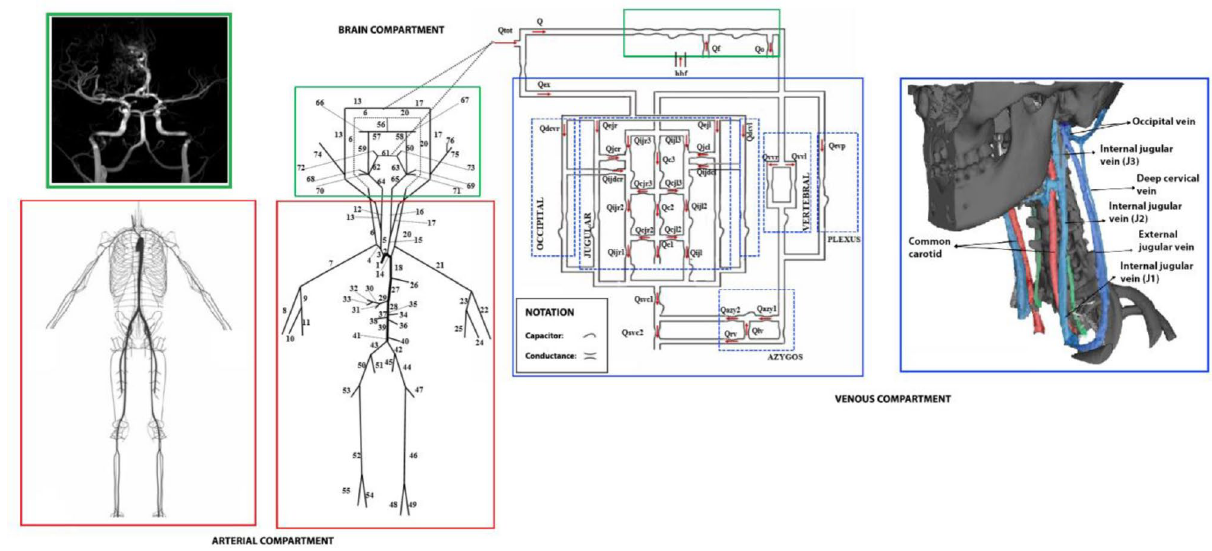
Figure 1. Mathematical model for the simulation of human circulation. Red boxes are the anatomy (left) and scheme (right) of the arterial tree. Green boxes are the anatomy (left), scheme (middle) of the Willis circle tree, and the scheme of the intracranial 0-D submodel (right). Blue boxes are the scheme (left) and anatomy (right) of the venous